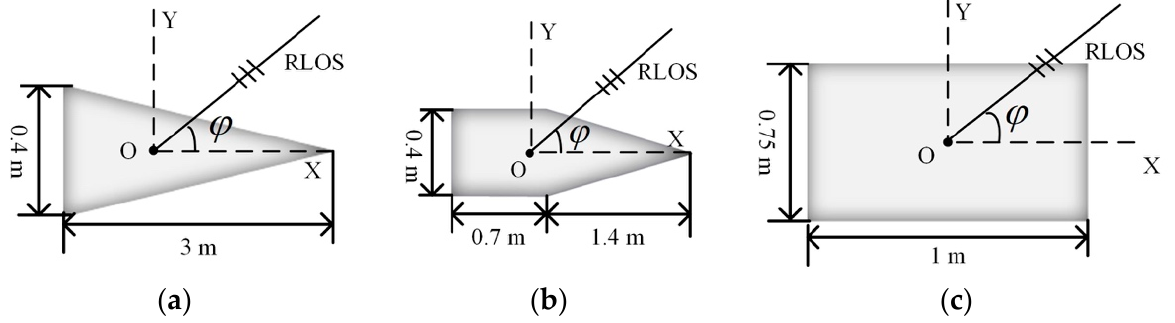
Figure 3. Sketch of three typical metal target models: ( a ) cone; ( b ) cone plus cylinder; ( c ) cylinder.